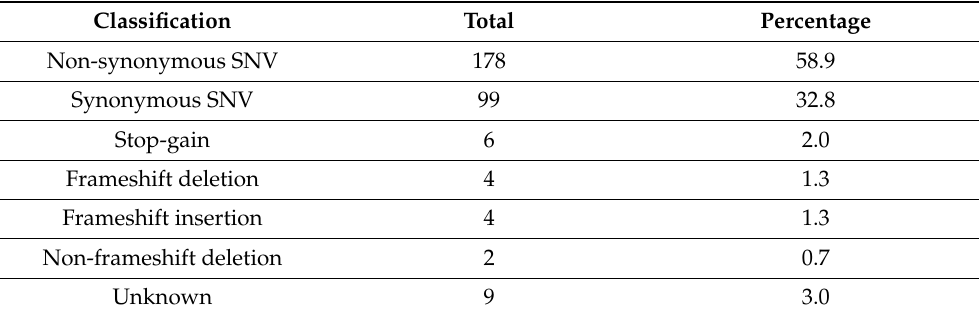
Table 2. Overview of the observed exonic alterations in cytochromes P450 by coding